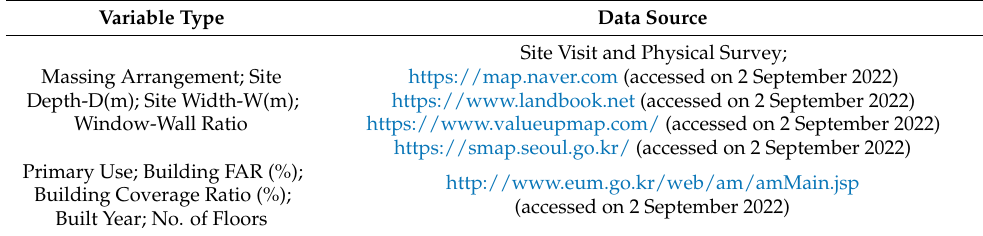
Table 1. Summary of the data sources for each variable.